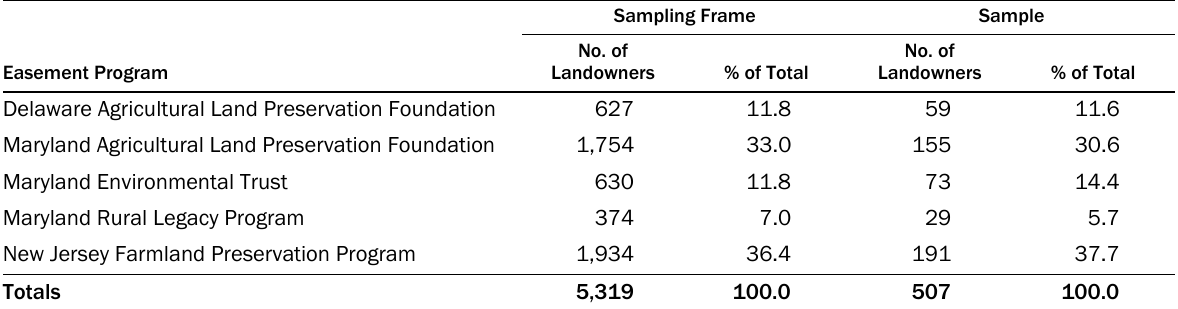
Table 1. Composition of Sampling Frame and Study